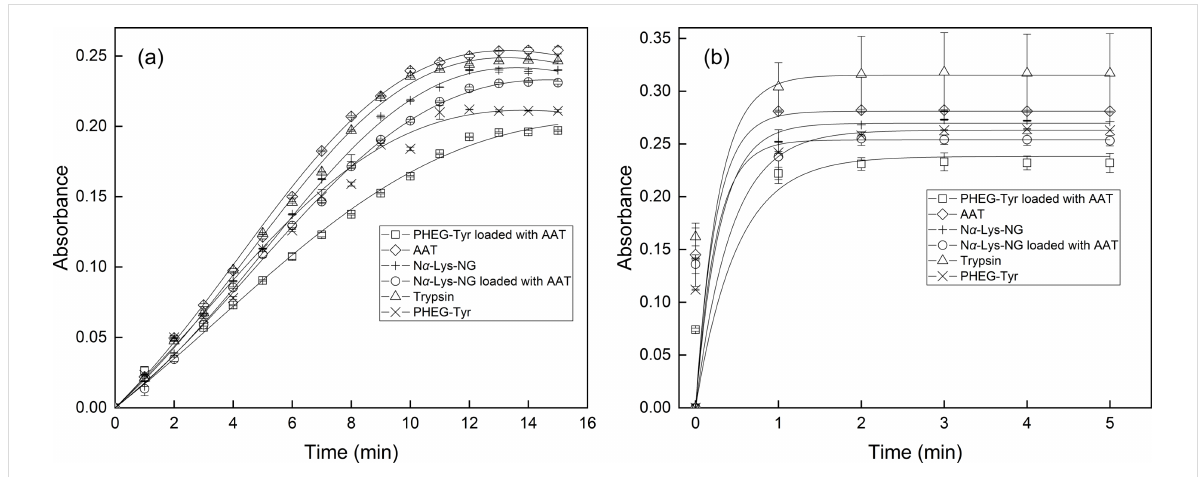
Figure 6: Spectrophotometric measurements of enzymatic assay of trypsin at trypsin/substrate ratio 1:50 (a) and 1:25 (b) using trypsin without inhibi- tion (triangles), AAT (diamonds), N α -Lys-NG nanogel loaded with AAT (circles), PHEG-Tyr nanogel loaded with AAT (squares), N α -Lys-NG nanogel (plus signs), and PHEG-Tyr nanogel (crosses). The lines are to guide the